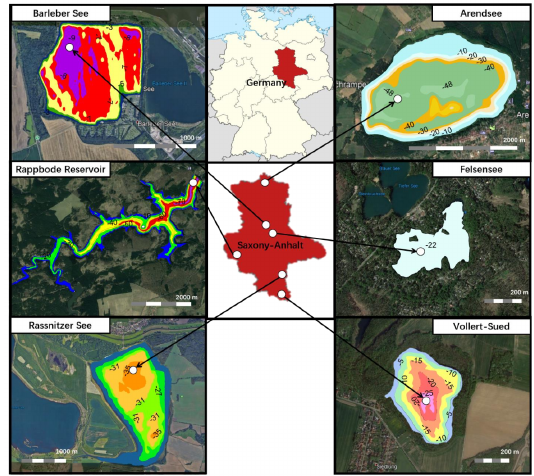
Figure 1. Location of investigated lakes; depth contour maps Arendsee, Rappbode Reservoir, Rass- nitzer See, Barleber See, Vollert-Sued,